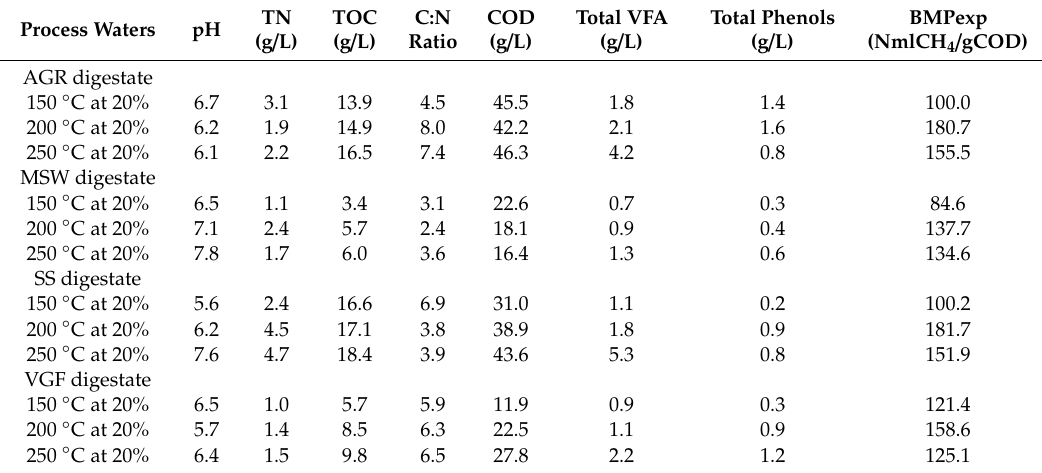
Table 5. Liquid analysis and experimental biochemical methane potential of 20% process